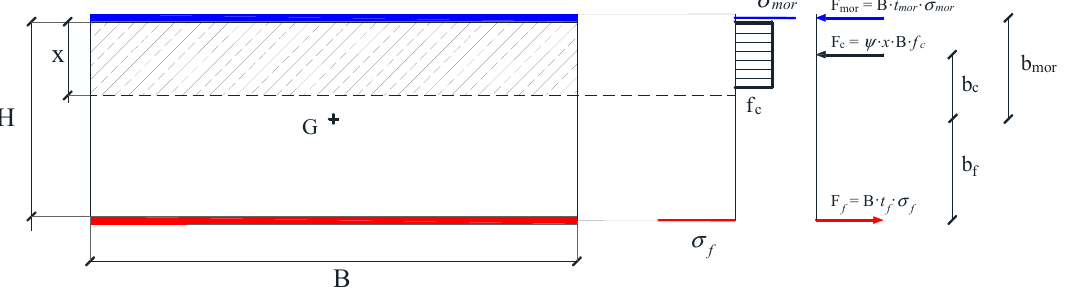
Figure 4. Equilibrium of strengthened masonry section including the e ff ect of mortar matrix of the composite in compression–dimensional form.